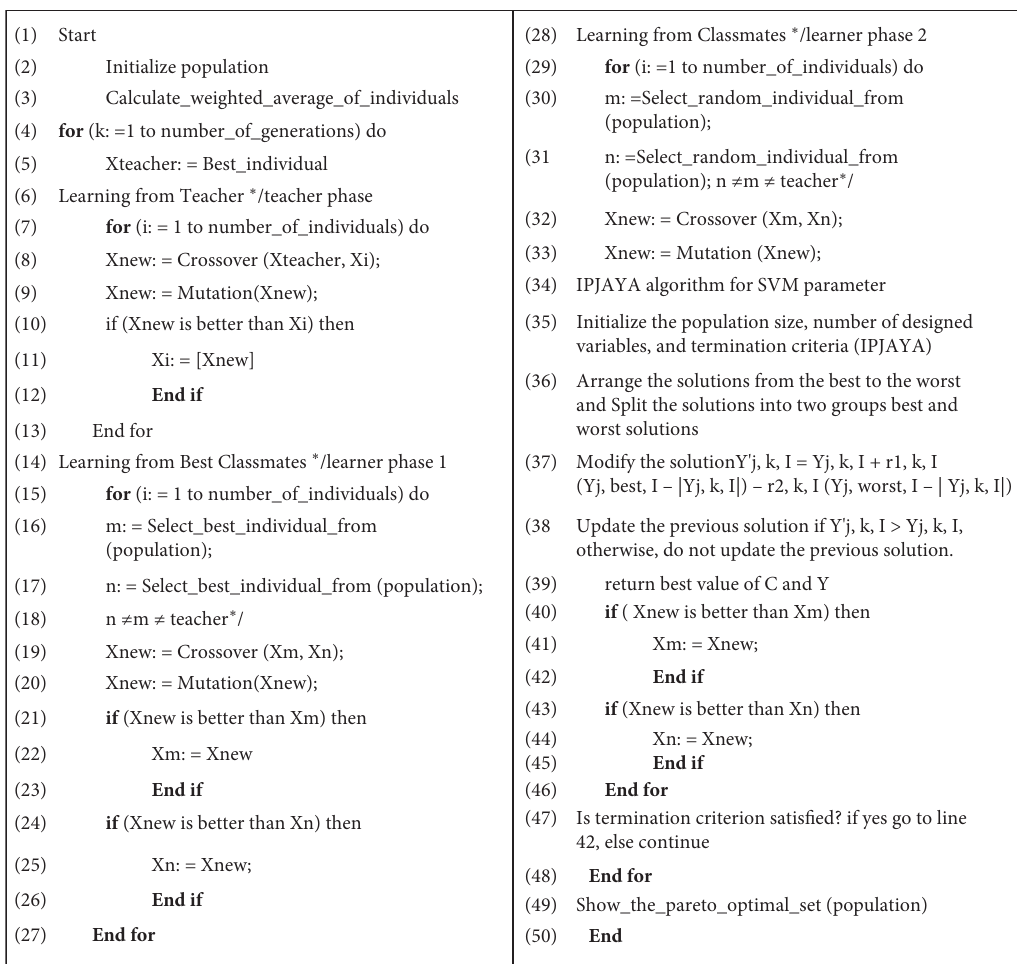
Figure 10: Proposed method